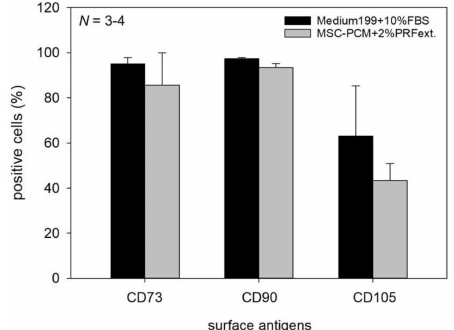
Figure 7. Effects of different culture media on the expression of surface antigens. Only periosteal sheets cultured with MSC-PCM + 2% PRFext were compared with the control sheets (Sample 21). X -axis: type of surface antigens. Statistical analysis was performed using the Mann–Whitney rank-sum test and no significant difference was observed between the two groups. N = 3 or 4